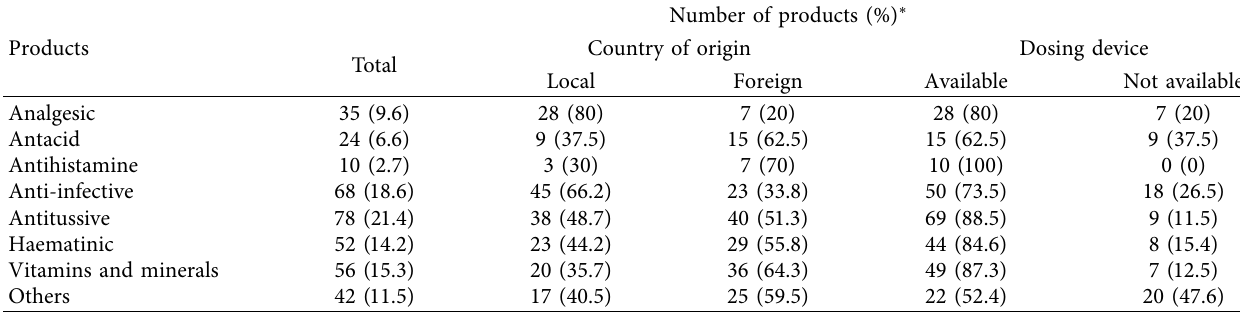
Table 1: Categories of oral liquid medicines studied.